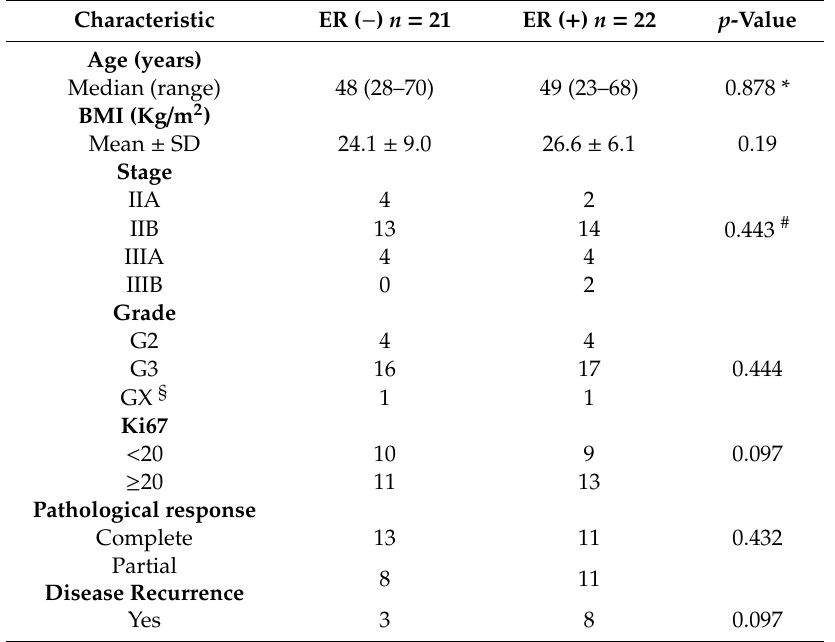
Table 1. Demographic and clinical characteristics of the HER2-positive patients as a function of the ER status. Characteristic ER ( − ) n = 21 ER ( + ) n = 22 p -Value Age (years) Median (range) 48